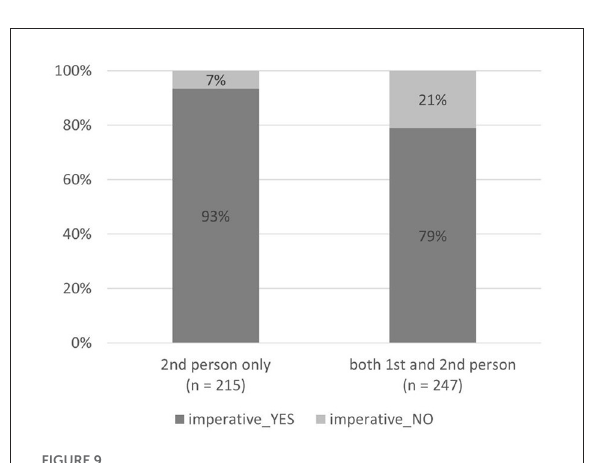
FIGURE9 Imperative mood and 2nd person with and without 1st person. FIGURE10